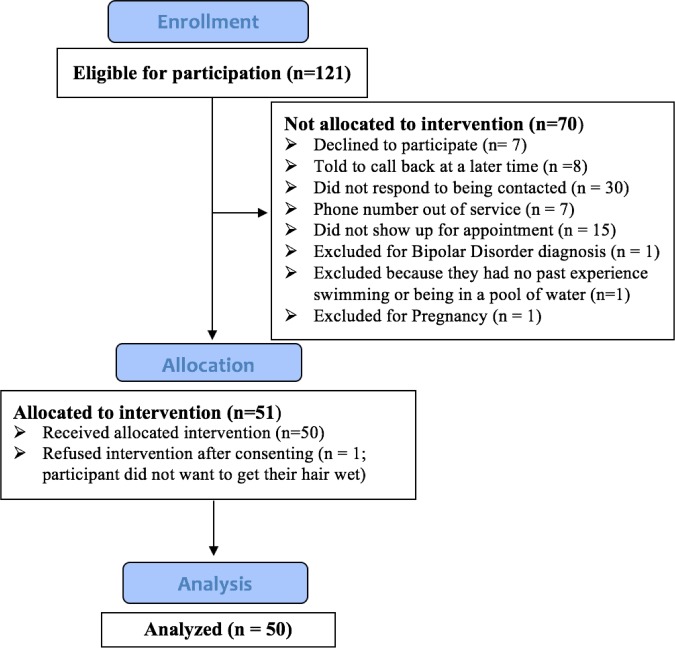
Flow diagram for study recruitment.